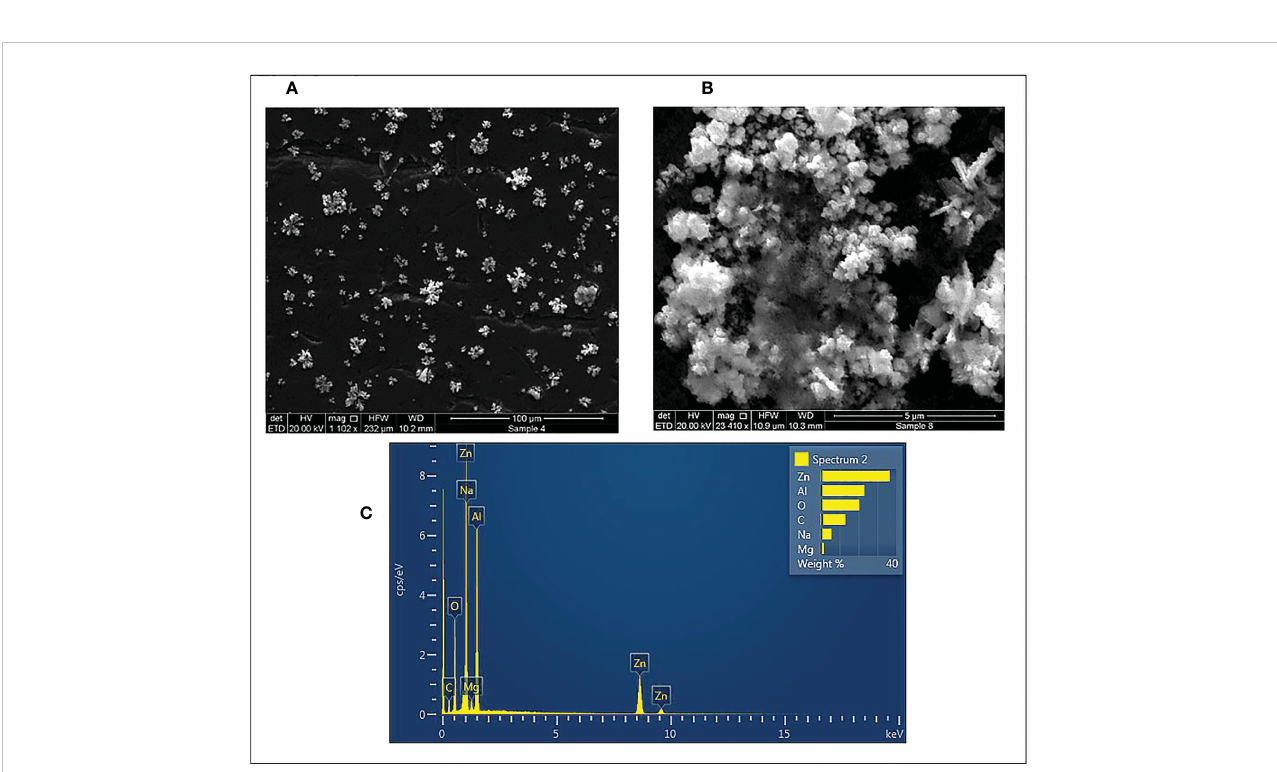
FIGURE 5 SEM micrographs 1102X (A) and 2340X (B) and, EDX spectra (C) of synthesized ZnO NPs using pecan leaf extract as a reducing agent. The inset bar plot of the EDX showed the percent weight of the proportion of Zn, Al, O, C, Na and